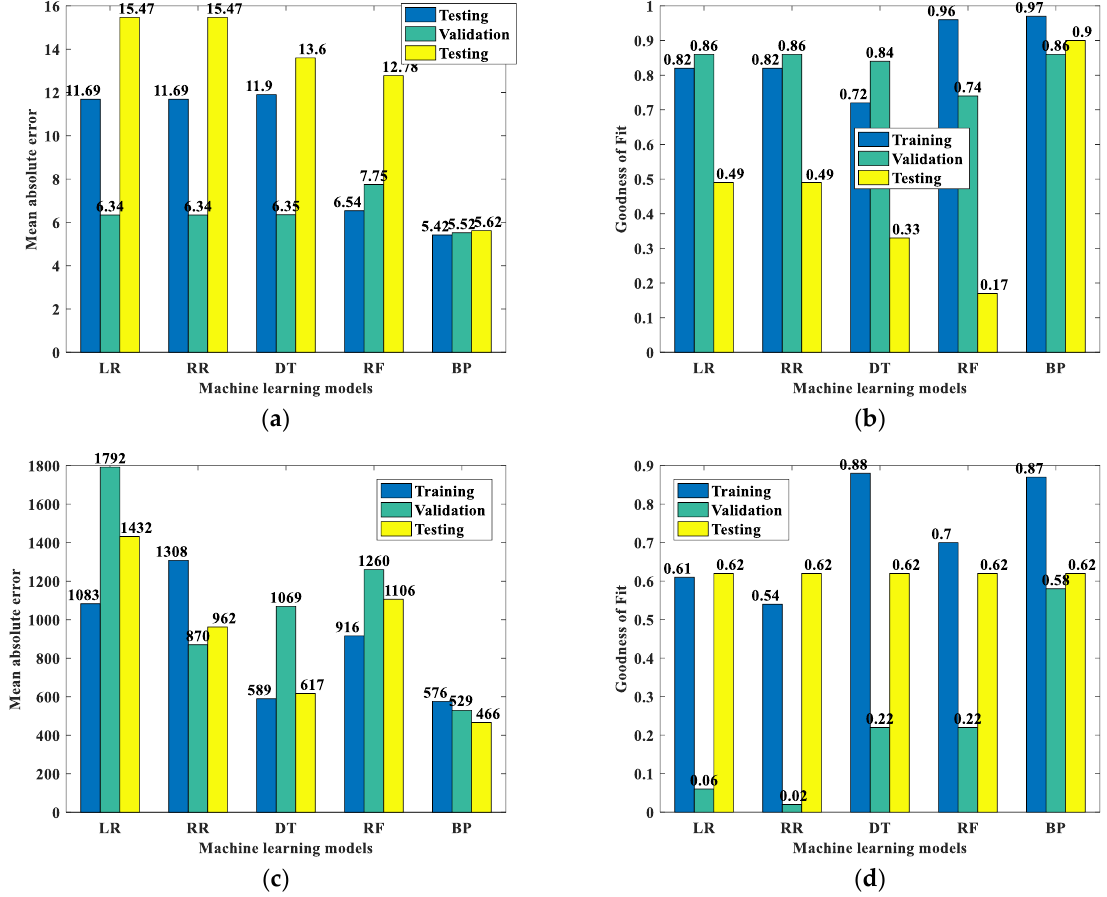
Figure 7. ( a ) MAE for PE debonding prediction model; ( b ) R 2 for PE debonding prediction model; ( c ) MAE for IC debonding prediction model; ( d ) R 2 for IC debonding prediction model.